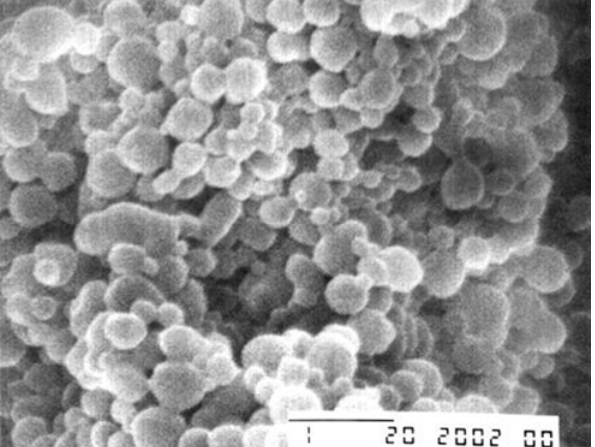
Figure 5. SEM micrograph of nanoparticles obtained by co-precipitation of the n -butyl hemiester of the alternating copolymer of maleic anhydride/tetraethylene glycol vinyl ether and HSA and coated with digalactosyl diacyl glycerol as targeting moiety (bar is 1 μ m)